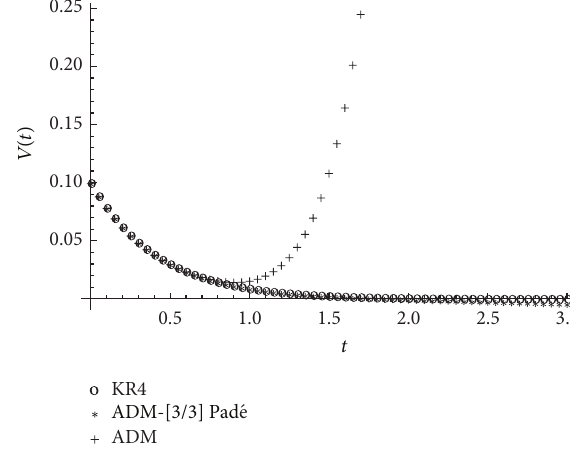
Figure 1: Curves of KR4, ADM-[3/3] Pad´e approximation, and ADM for 𝑇(𝑡) .